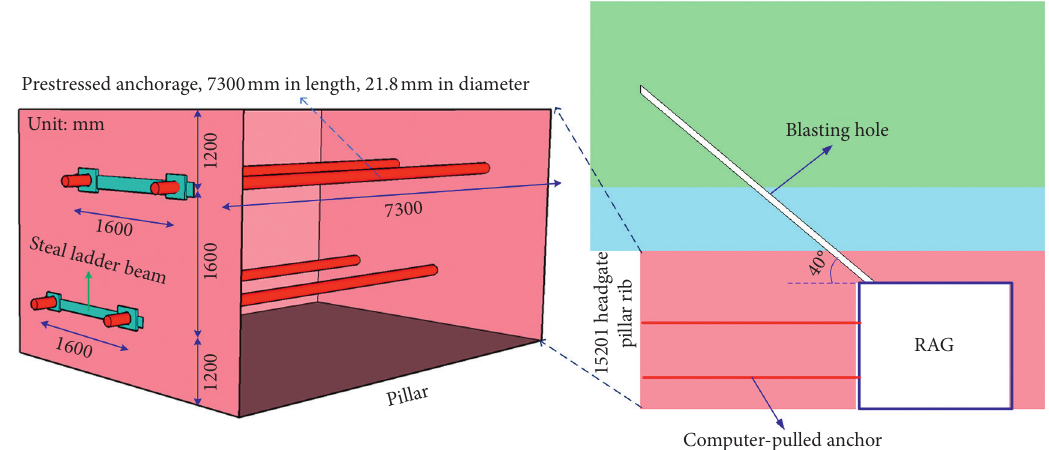
Figure 17: Controlling pattern of the 15202 tailgate.